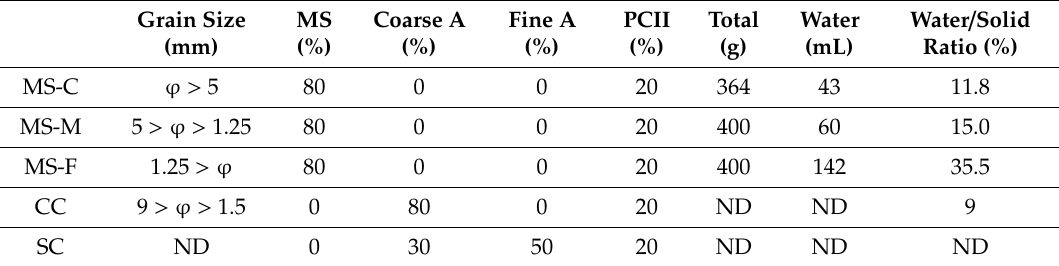
Table 1. Composition (wt%) of the specimens made from three fractions of mixed slag (MS) and Portland cement type II (PCII) compared with coarse porous (CC) and standard concrete (SC).